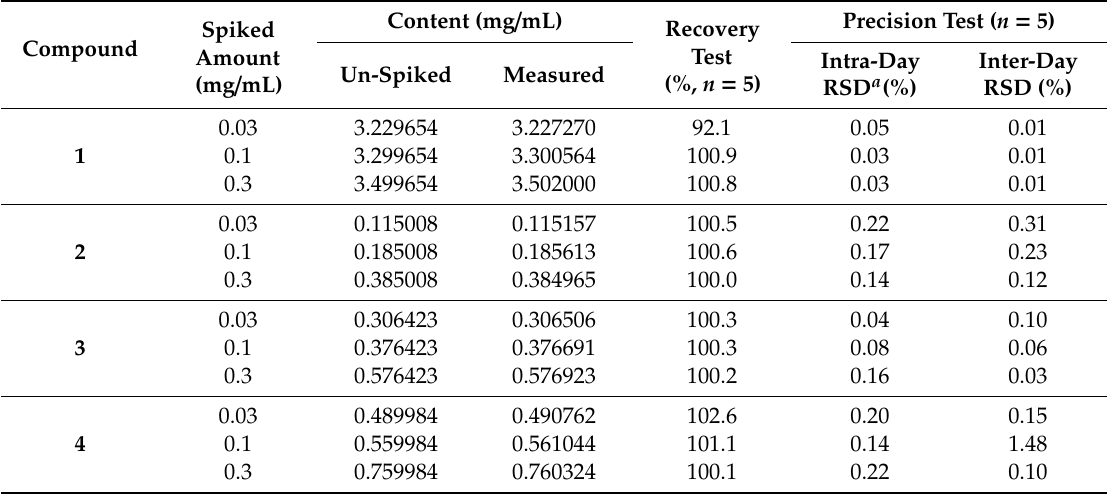
Table 2. Accuracy, intraday and interday precision of the standard compounds in